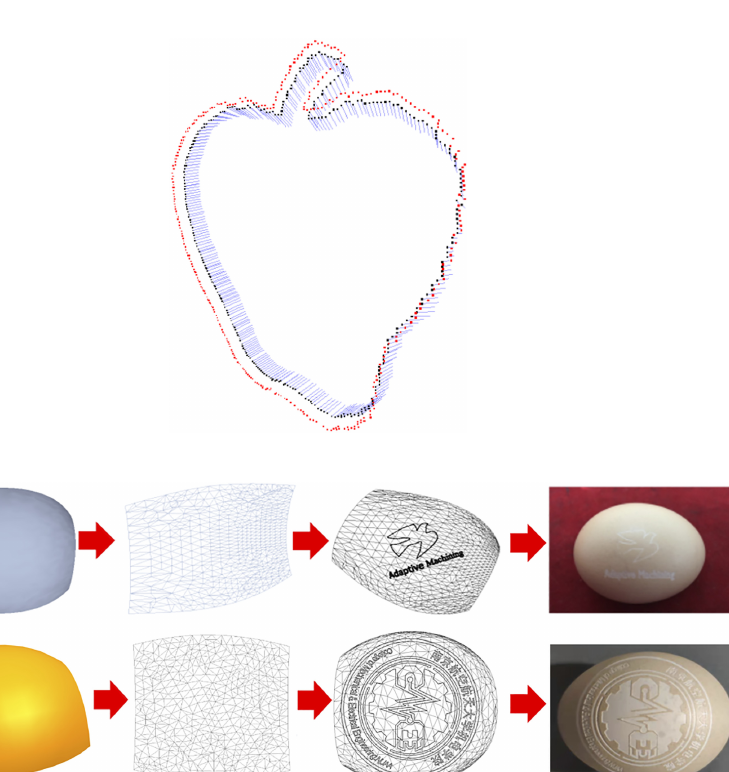
Figure 17. Verification of the proposed adaptive sculpting method